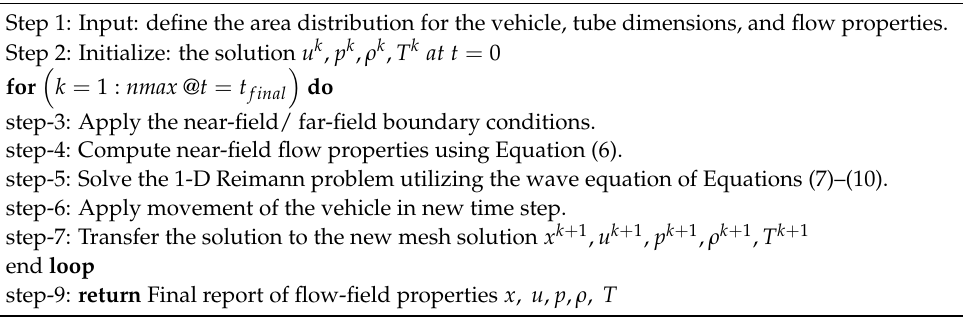
Algorithm 1 Method of Characteristics Solution Algorithm